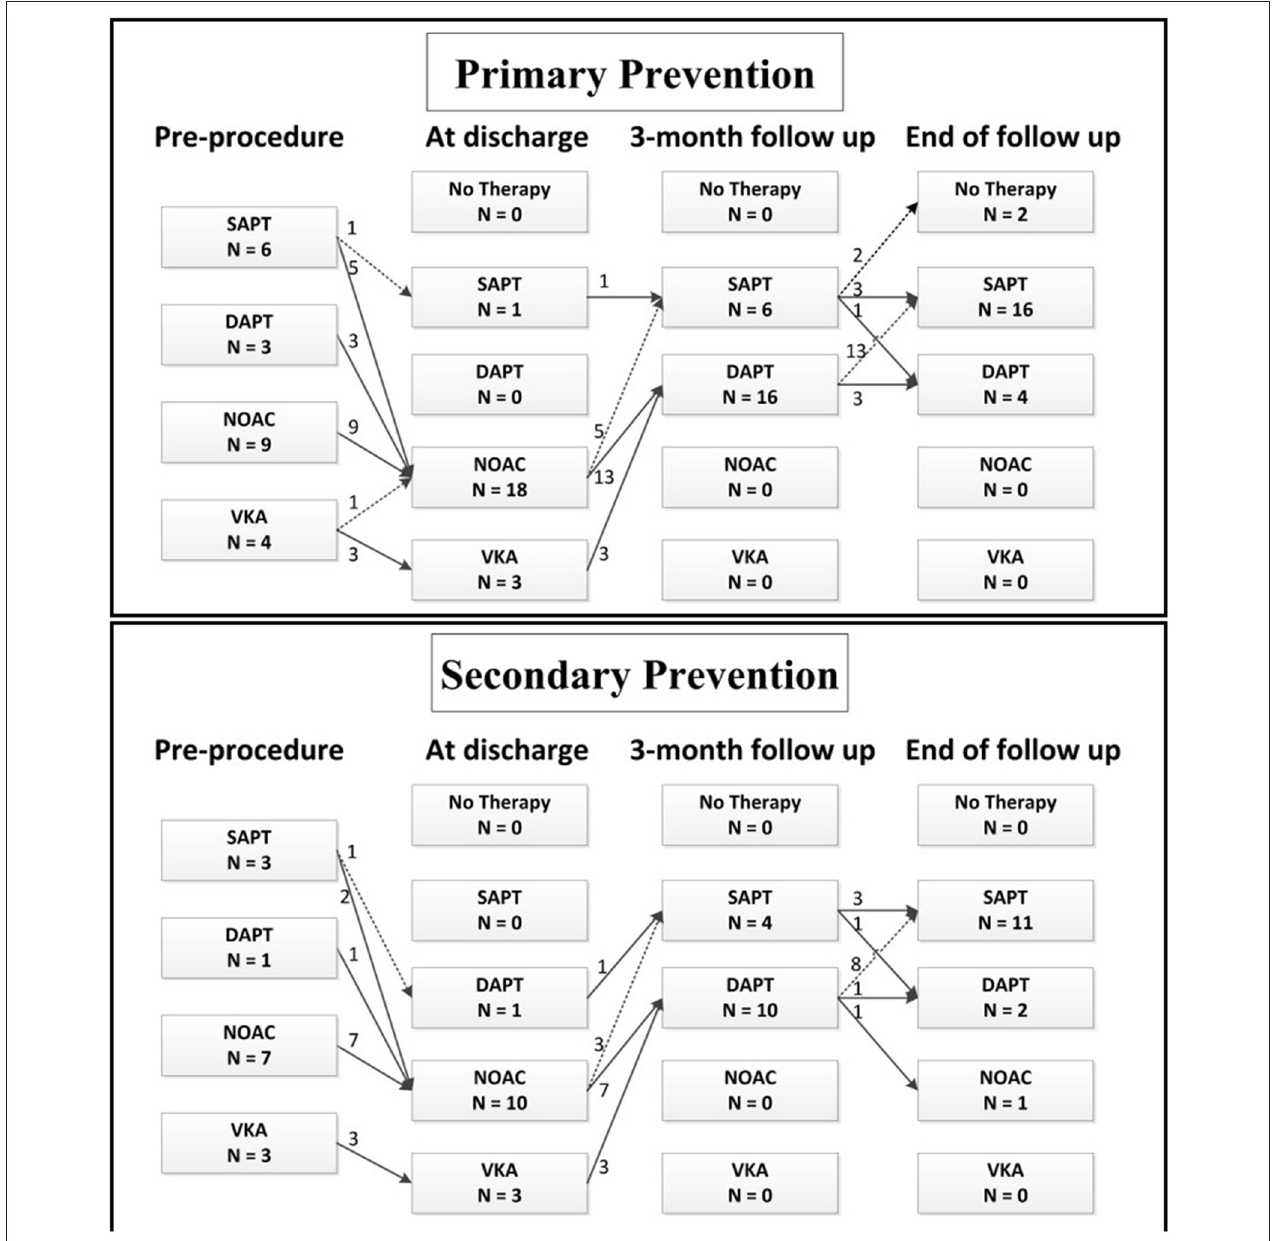
FIGURE 1 | Antithrombotic regimens pre-procedure, at discharge, at 3 months and at the end of follow-up. DAPT, dual antiplatelet therapy; NOAC, novel oral anticoagulation; SAPT, single antiplatelet therapy; VKA, vitamin K antagonist.